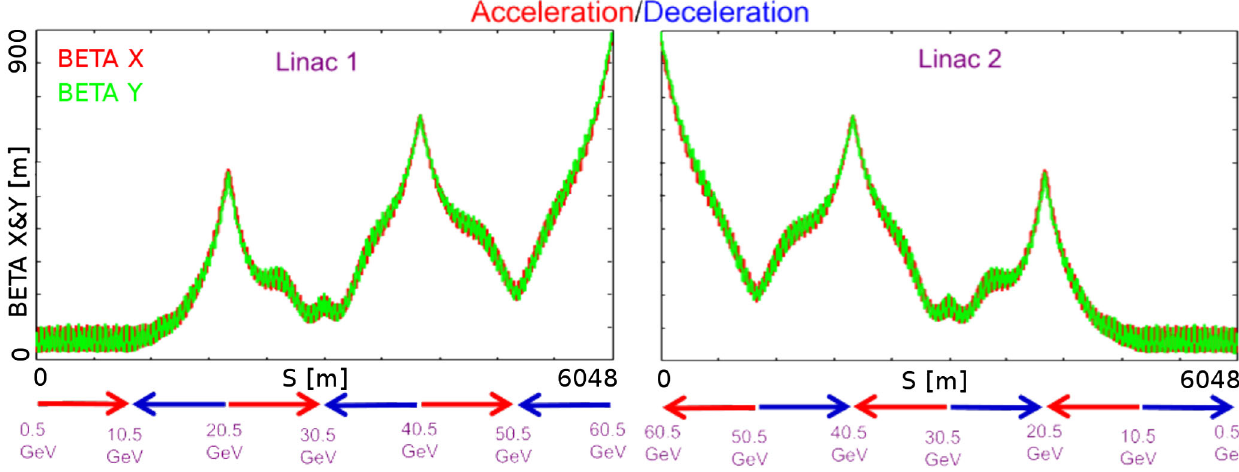
FIG. 2. Optics functions in the linacs for the subsequent passages. The red (blue) arrows indicate the accelerating (decelerating) passages.